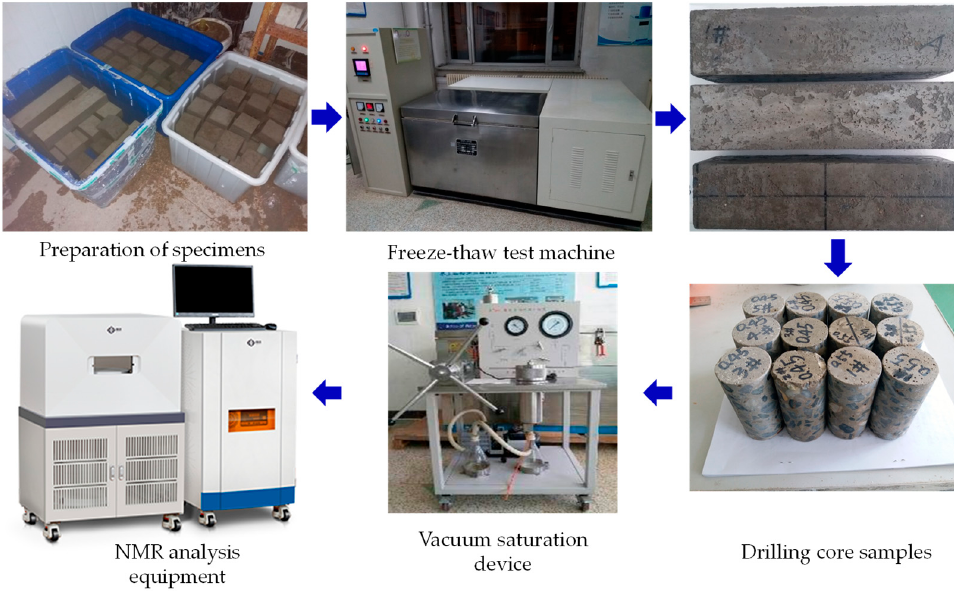
Figure 6. Flow chart of NMR test.